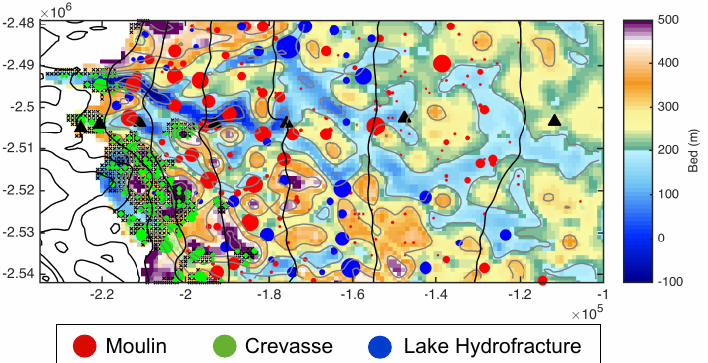
Figure 5. Modelled supraglacial input in the Russell Glacier area for the integrated model domain in 2009. Meltwater pathways are denoted by circles of different colours, with red, green, and blue corresponding to moulins, crevasses, and lakes, respectively. Circle areas are scaled by volume. GPS stations are shown as black triangles. Hatch marks show grid cells calculated as crevassed. Crevasse inputs appear within hatched areas due to resampling from 90 to 1000m resolution. Background is basal topography from BedMachine2 reinterpolated at 1000m. Light grey contours correspond to 100m basal contours. Black lines correspond to 200m surface topography contours at the same elevations as in Fig.